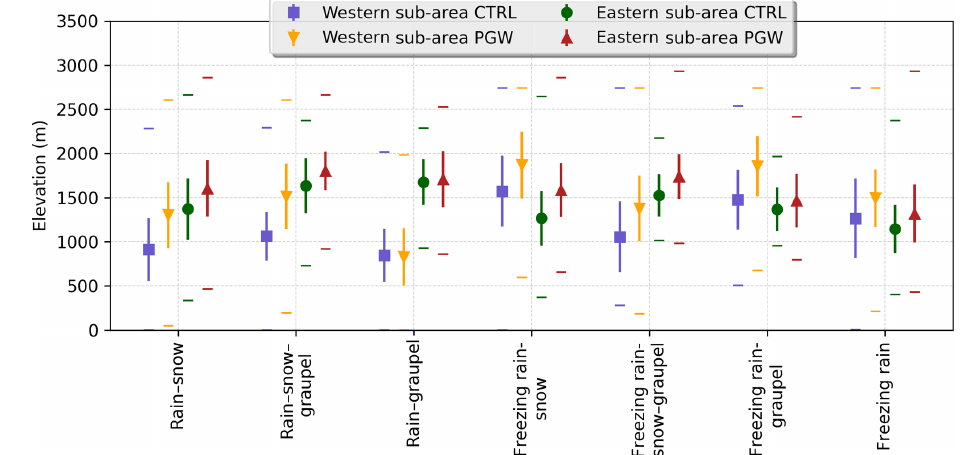
Figure 11. Average elevation of transition region categories over the western and eastern sub-areas under both the CTRL (green circles and purple squares) and PGW (red triangles and orange upside-down triangles) and their standard deviations. Minimum and maximum elevations are denoted by horizontal